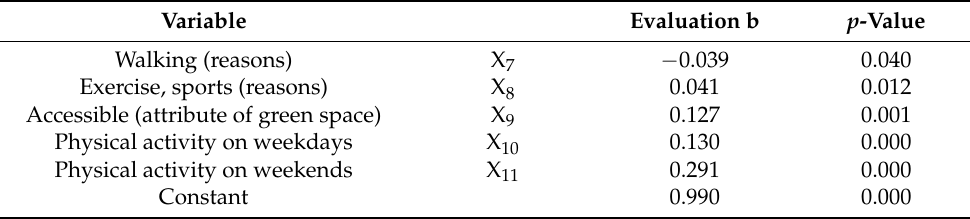
Table 6. Parameter values of the multiple regression model describing the relationship between health declaration Green and Physical Activity and greenery preferences and the corresponding p